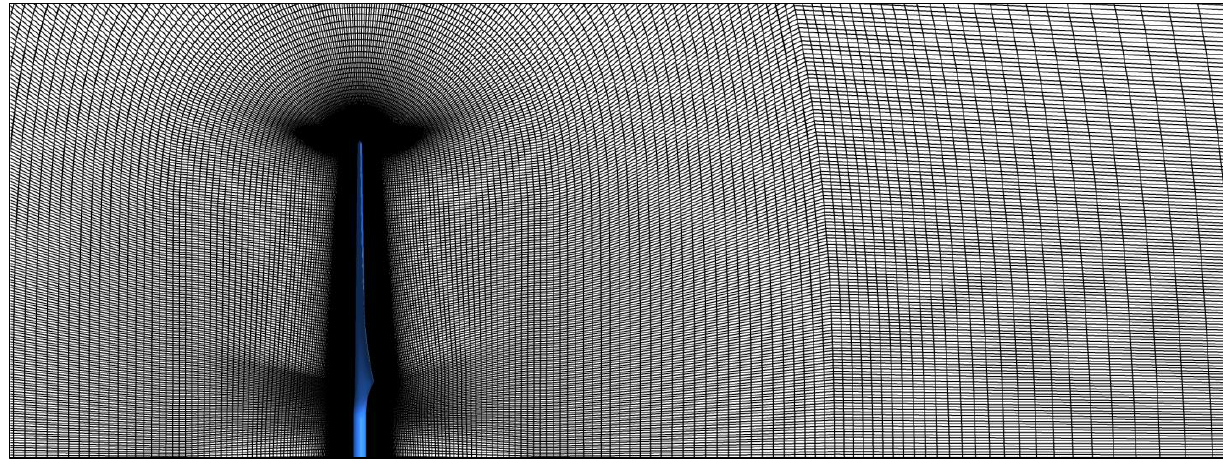
Figure 6. Volume mesh section normal to the blade pitch axis at r/R = 0.95.